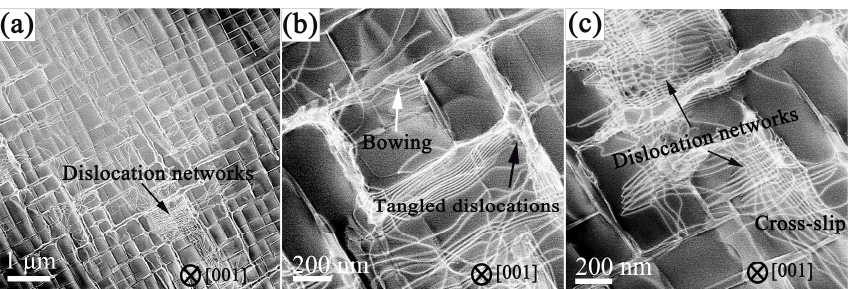
Figure 6. Transmission electron microscope (TEM) bright field (BF) images showing dislocation configurations of an alloy at 980 ◦ C under ∆ ε t /2 = 0.6%: ( a ) distribution of the dislocations; ( b ) bowing and tangled dislocations; and ( c ) formation of dislocation networks.